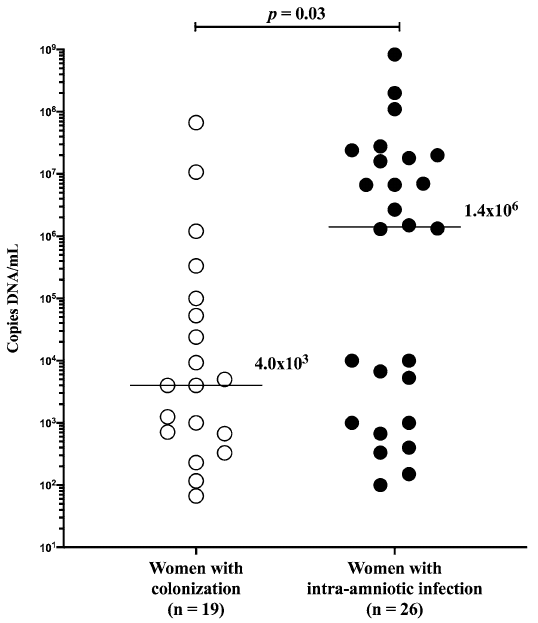
Figure 1. Comparison of the load of Ureaplasma spp. DNA in the amniotic fluid between women with colonization and those with intra-amniotic infection. The median values are